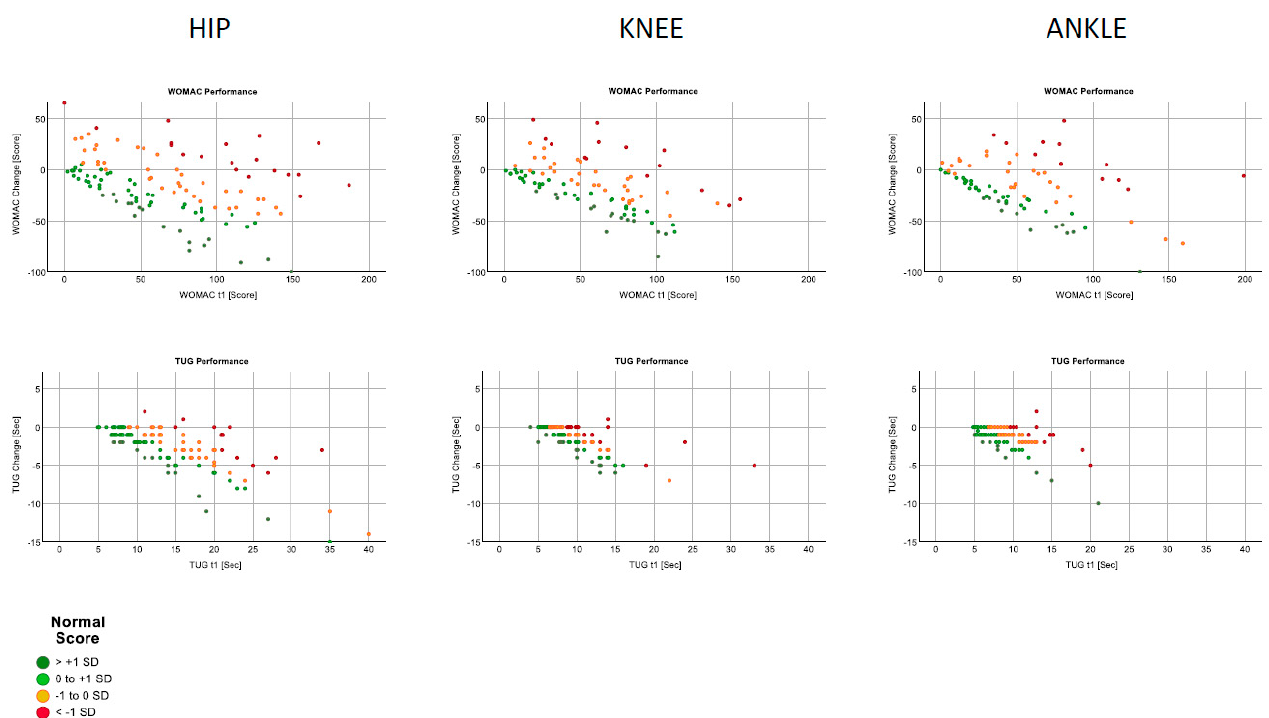
Figure 2. TUG and WOMAC improvements vs. performance